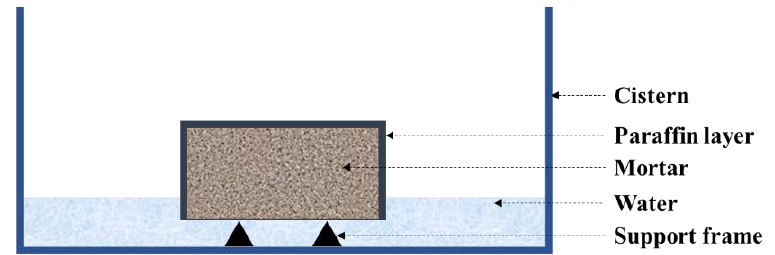
Figure 3. Schematic diagram of capillary water absorption test.